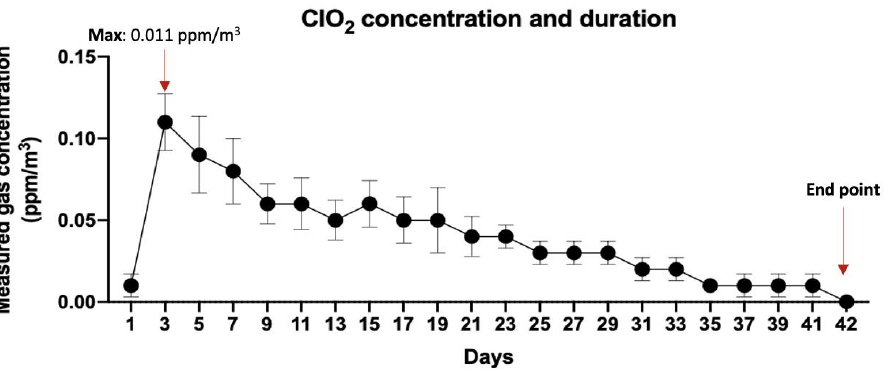
Figure 1. Safe duration and concentration of ClO 2 gas controlled by Dr.CLO TM . After activation of Dr.CLO TM , the maximum concentration of ClO 2 gas was 0.011 ppm/m 3 . It was confirmed that the concentration was stably maintained between 0.000 and 0.011 ppm/m 3 for 42 days after Dr.CLO TM activation. Error bars represent mean ±